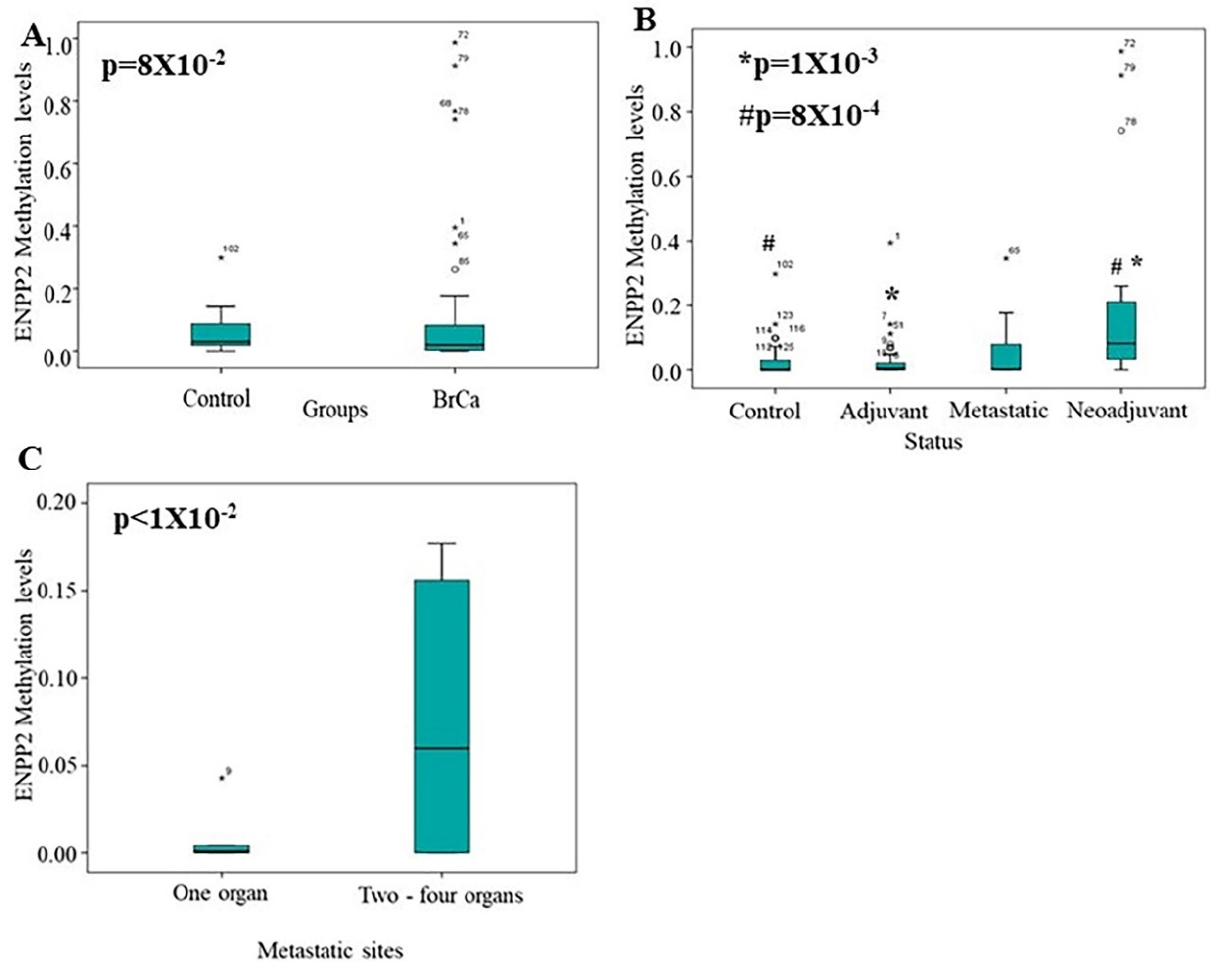
Figure 5. Median methylation levels of ENPP2 . Boxplots depict methylation levels in ccfDNA of ( A ) BrCa compared to control group and ( B ) in each studied group separately; ( C ) BrCa patients with one metastatic site compared to those with two or more. Abbreviations: BrCa: breast cancer, * Adjuvant in relation to Neoadjuvant, # Control in relation to